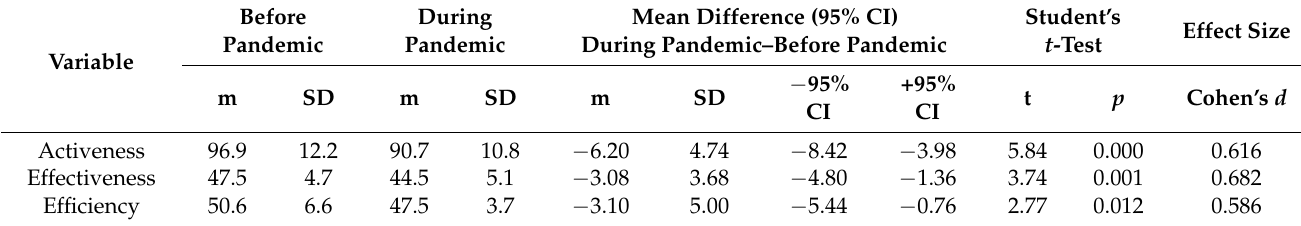
Student’s Effect Size t -Test